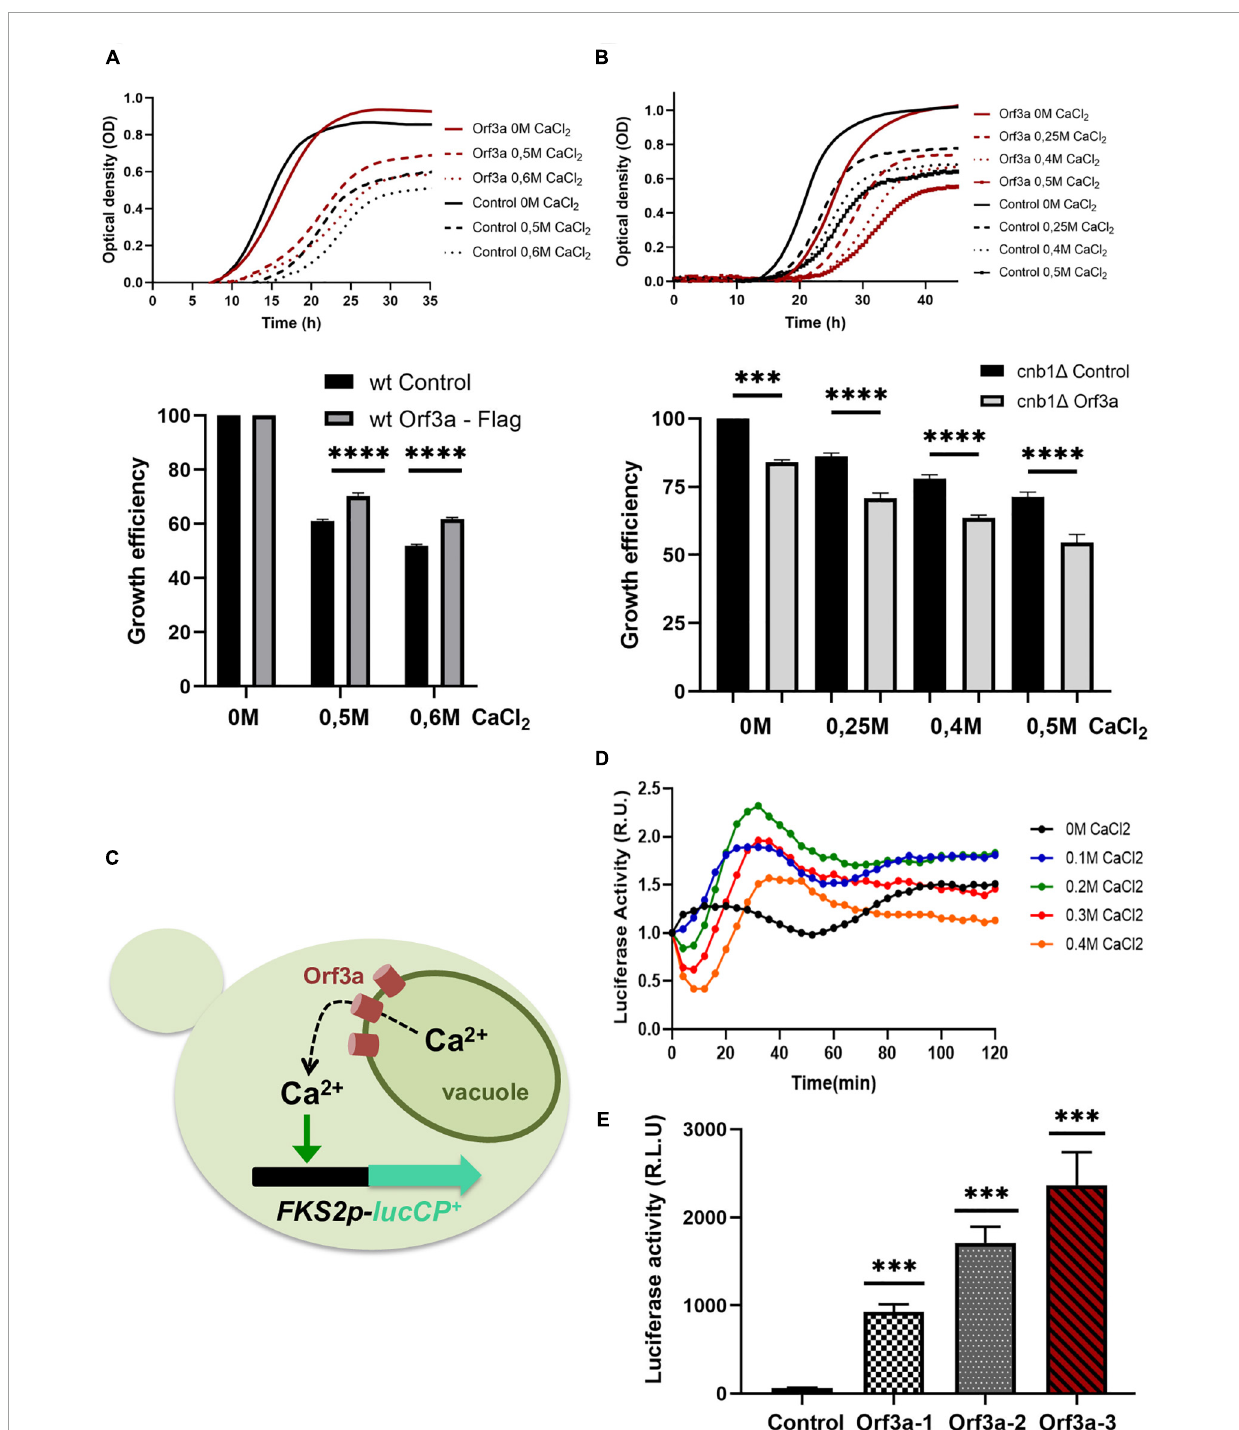
FIGURE6 Severe acute respiratory syndrome coronavirus-2 (SARS-CoV-2) ORF3a modulates intracellular Ca 2 + homeostasis in yeast. (A) ORF3a confers Ca 2 + tolerance in yeast wild type cells. Upper panel: Growth of constitutively ORF3a overexpressing or control cells in SD medium with the indicated Ca 2 + concentrations. Lower panel: Representation of the relative growth efficiency. Growth of the control cells without addition of Ca 2 + was set to 100%. (B) ORF3a confers Ca 2 + sensitivity in yeast cnb1 mutants defective for calcineurin signaling. Experimental procedure same as in (A) . Three independent biological samples were analyzed. Data are mean ± SD. (C) Experimental model connecting ORF3a mediated Ca 2 + efflux and its detection by the FKS2-luciferase live cell reporter. (D) The FKS2-lucCP + reporter is activated by Ca 2 + in a dose-dependent manner. Yeast wild type cells harboring the FKS2-luciferase reporter plasmid were grown in SD medium and the indicated Ca 2 + doses added at time point 0. The luciferase activity was determined continuously by the light emission from live cell populations. Data are mean values from three biological replicates. (E) Constitutively overexpressed ORF3a activates the Ca 2 + sensitive FKS2-luciferase reporter. Three different ORF3a overexpressing yeast cell lines were compared to control cells. Three biological replicates were analyzed. Data are mean ± SD. (A,B,E) p -values indicate significant differences between control and overexpressor cells according to the unpaired Student’s t -test; ∗∗∗ p < 0.001; ∗∗∗∗ p <